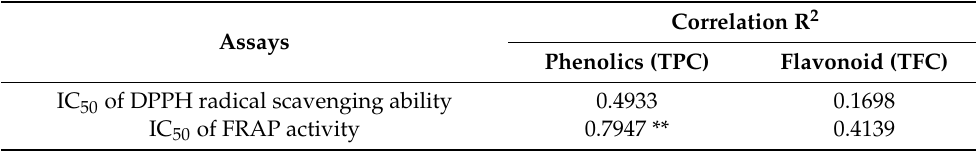
Table 4. Correlations between the pseudo-IC 50 values of antioxidant activities and phenolics and flavonoids content of samples tested.